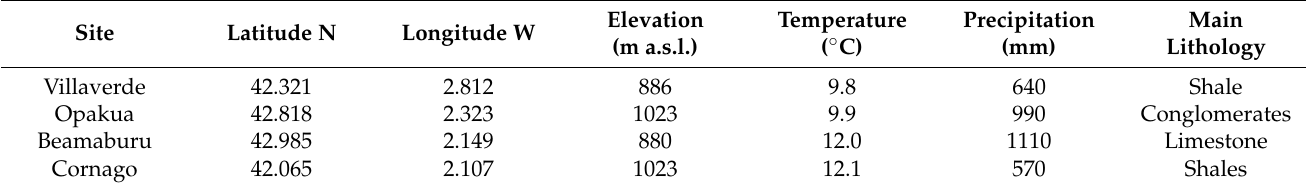
Table 1. Characteristics of the sampled sites. Climate data are